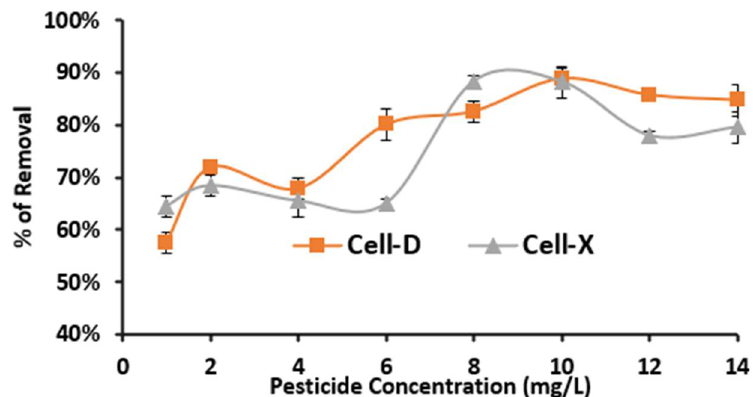
Figure 6. Effect of difenoconazole initial concentration on adsorption efficiency of Cell-X and Cell- D (temperature: 20 °C, dosage: 10 mg, volume: 10 mL).